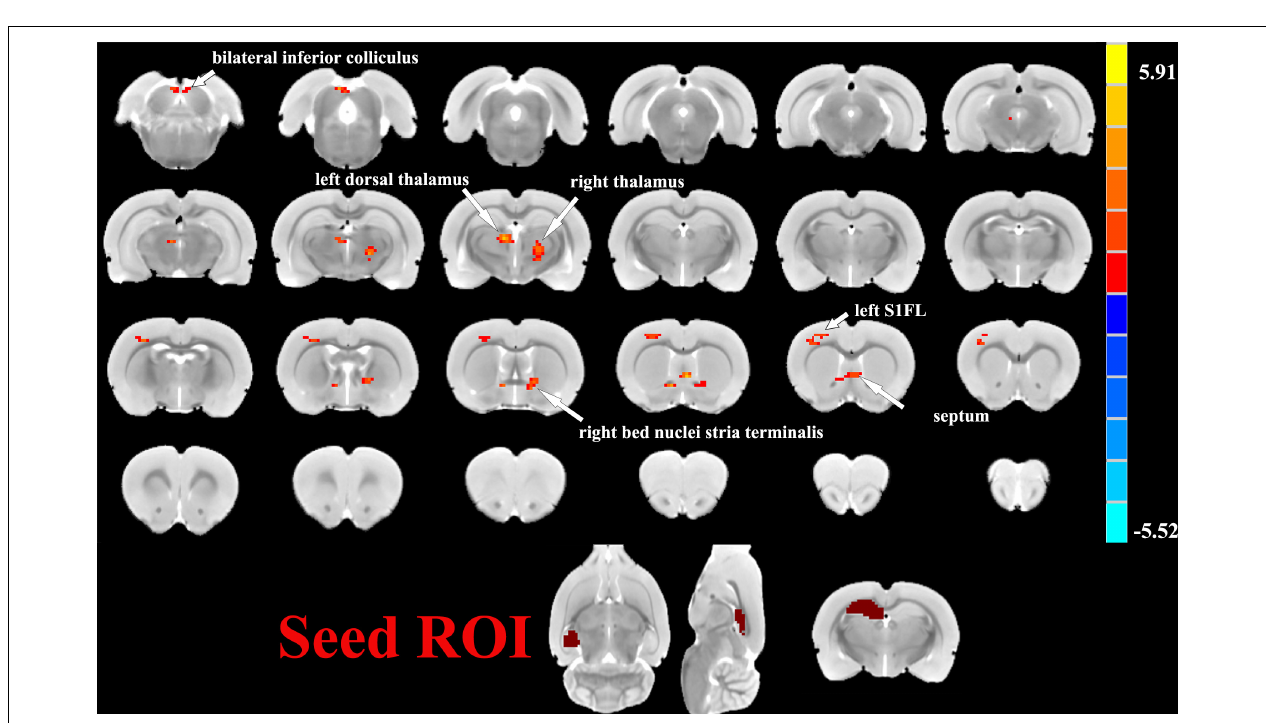
FIGURE 3 | Two sample t -test functional connectivity (FC) analysis selecting the bilateral hippocampus as seed between the SAE and control groups. Compared to the control group, FC was higher between the bilateral hippocampus and thalamus, septum, bed nuclei stria terminalis (BNST), left primary forelimb somatosensory cortex (S1FL), primary motor cortex (M1), and inferior colliculus in the SAE group.